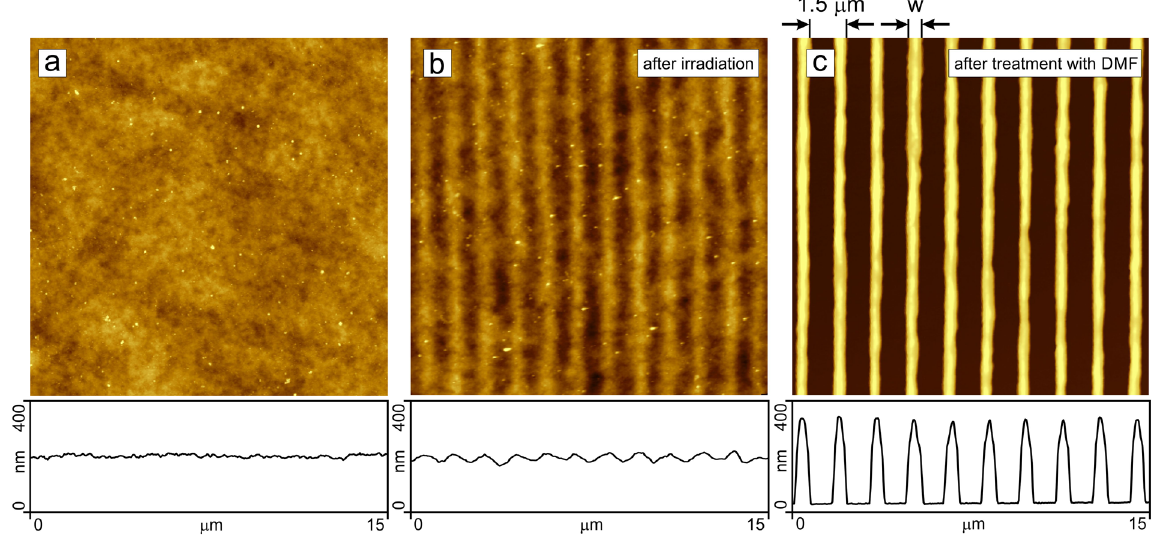
Figure 3. AFM micrographs of the PMAA brush loaded with azo-AuNPs before irradiation ( a ), after irradiation during 10 minutes with an IP at λ = 325 nm ( b ), and after subsequent treatment with good solvent (DMF) ( c ). The corresponding cross-sections are shown